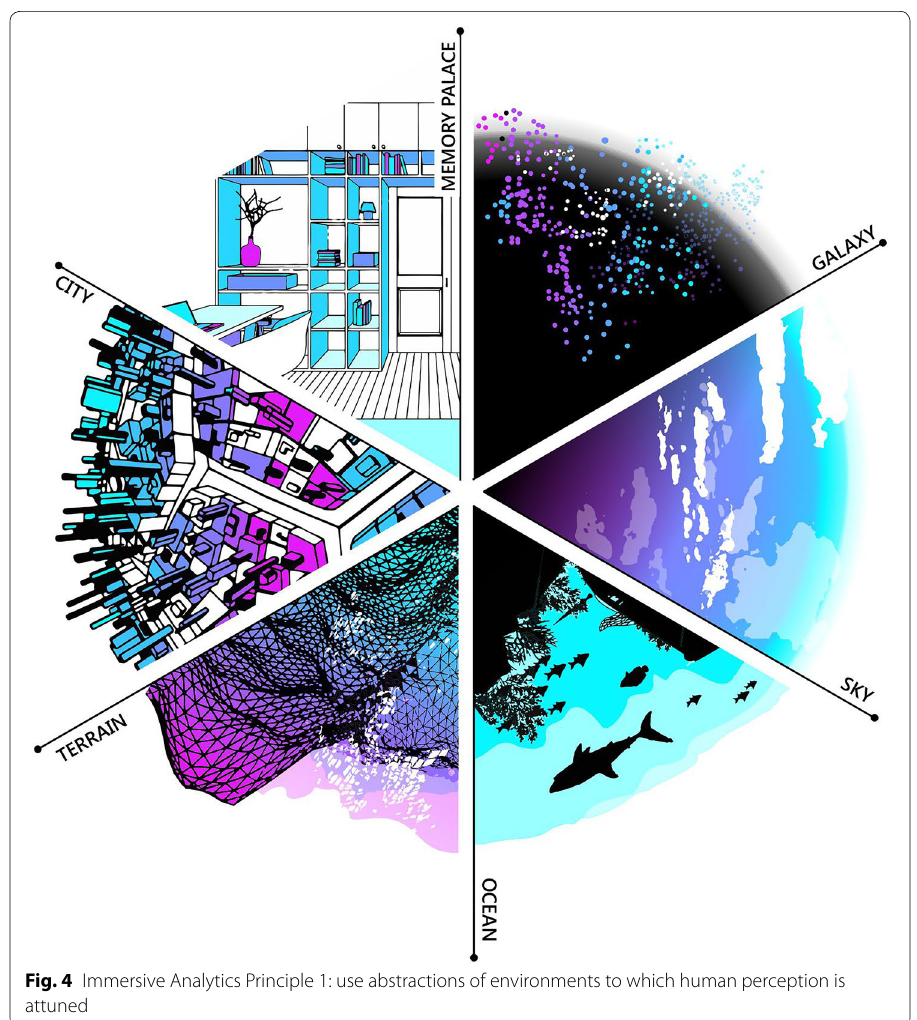
Fig. 4 Immersive Analytics Principle 1: use abstractions of environments to which human perception is attuned